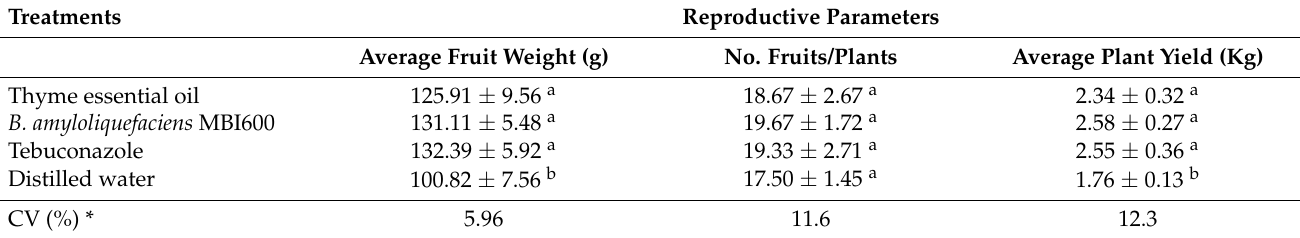
Table 5. Effect of the application of thyme essential oil on the yield parameters of tomato plants infected by Alternaria linariae